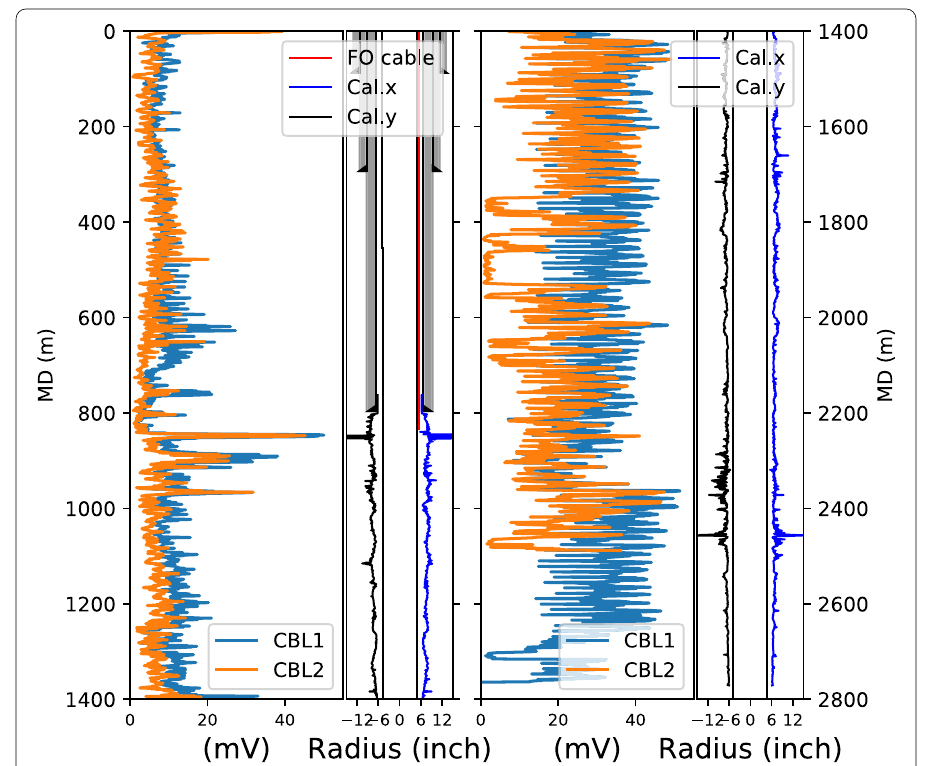
Fig. 3 Two consecutive cement bond logs after the end of the cementing operation. CBL1: September 6th after 14–21 h curing. CBL2: September 7th 33-40 h curing. A well completion schematic with the caliper log is shown next to the CBL data. Depth reference is surface. Figure modified from (Stefánsson et al.